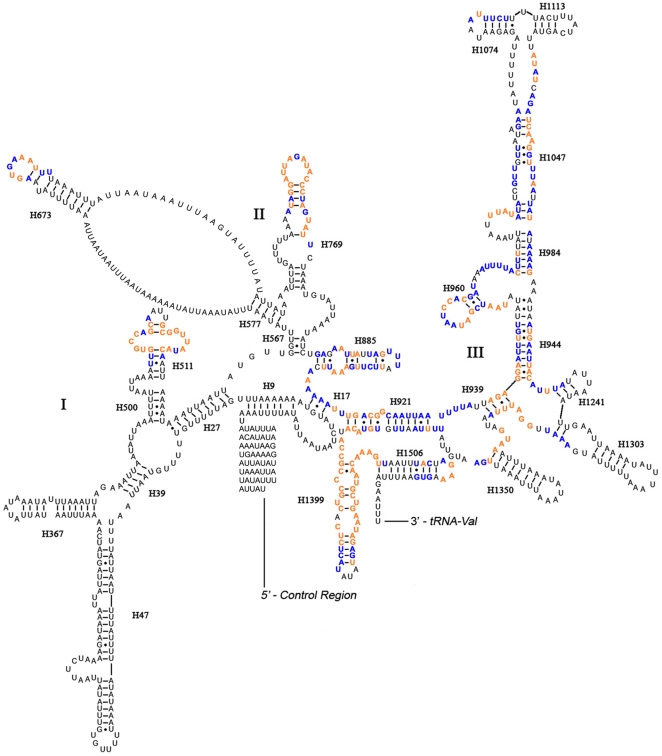
Predicted secondary structure of the rrnS gene in Stenopirates sp.The nucleotides showing 100% identities among true bugs are marked with orange color, and ≥75% identities are marked with blue color. Roman numerals denote the conserved domain structure. Inferred Watson-Crick bonds are illustrated by lines, GU bonds by dots.